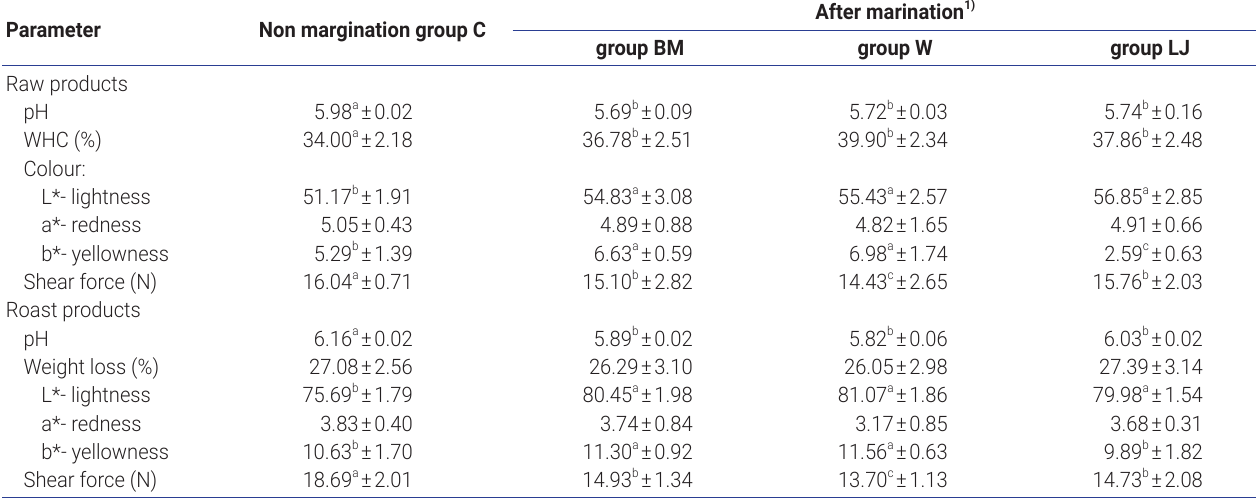
Table 1. The effect of marinating on the technological characteristics of raw and roasted products